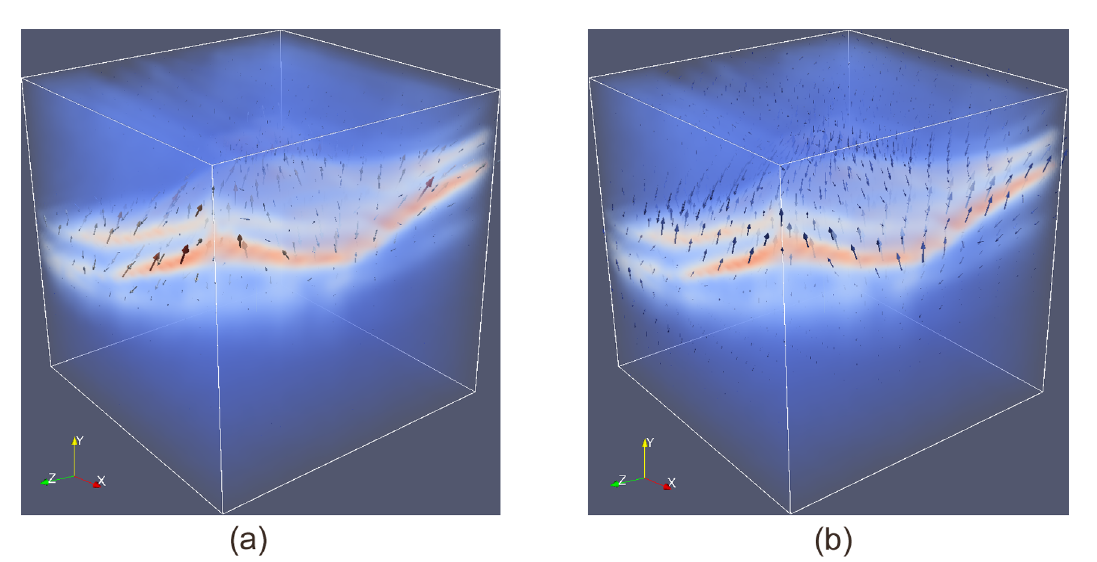
Figure 4. Impact of regularization on the deformation field of a 3D OCT volume. (a) Deformation field before regularization; (b) Deformation field after regularization.